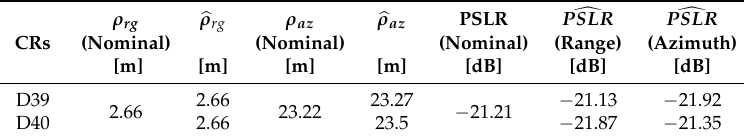
Table 4. Quality parameters for the corner reflectors focused through the presented algorithm within burst 8 of sub-swath 1: the nominal and estimated spatial resolutions along range ( ρ rg and ˆ ρ rg , respectively), along azimuth ( ρ az and ˆ ρ az , respectively), the nominal and estimated PLSR ( PSLR and (cid:92) PLSR , respectively) along range and azimuth are presented.